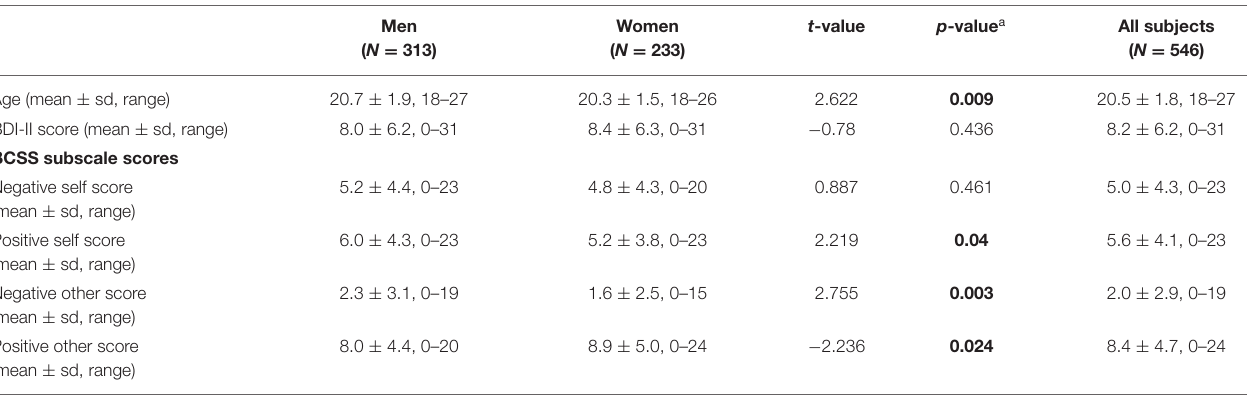
TABLE 1 | Demographics of all variables in the healthy subjects.